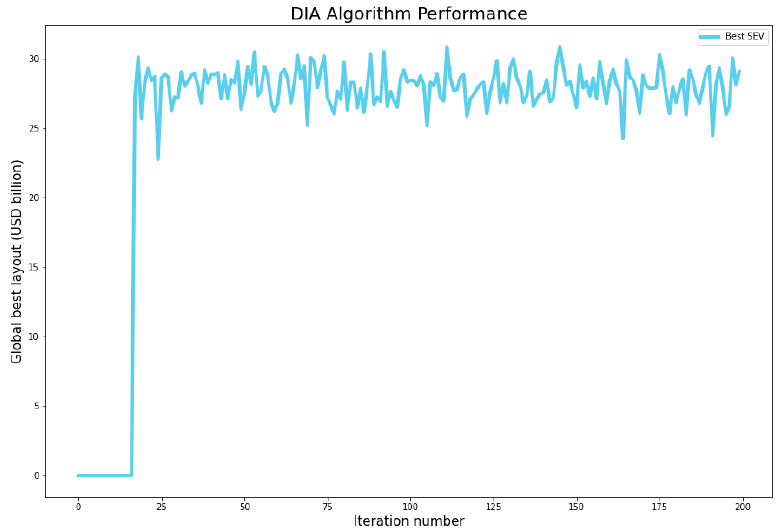
Figure 6. Scenario A: optimum solution convergence using the DIA. Source: [3].